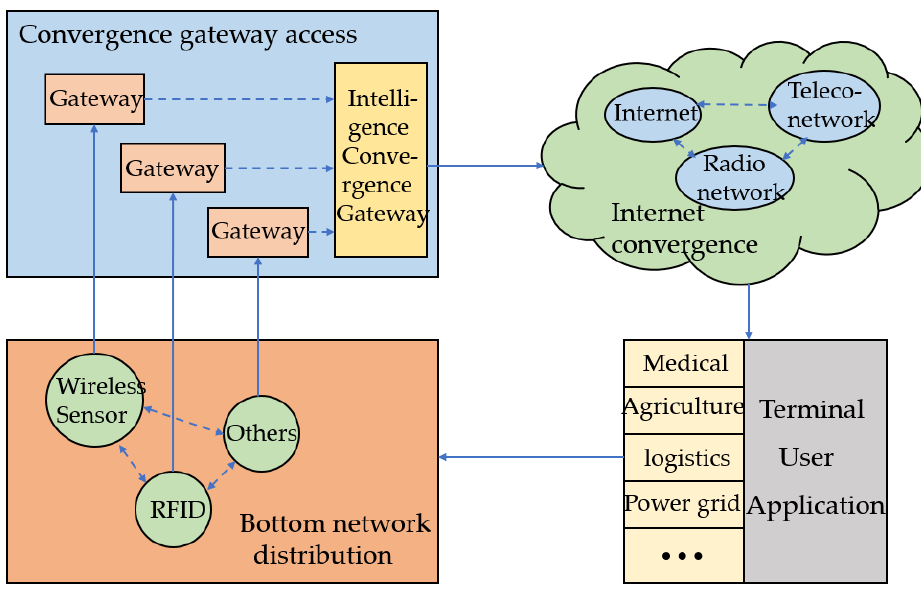
Figure 1. The Internet of Things system architecture of a wireless sensor network.